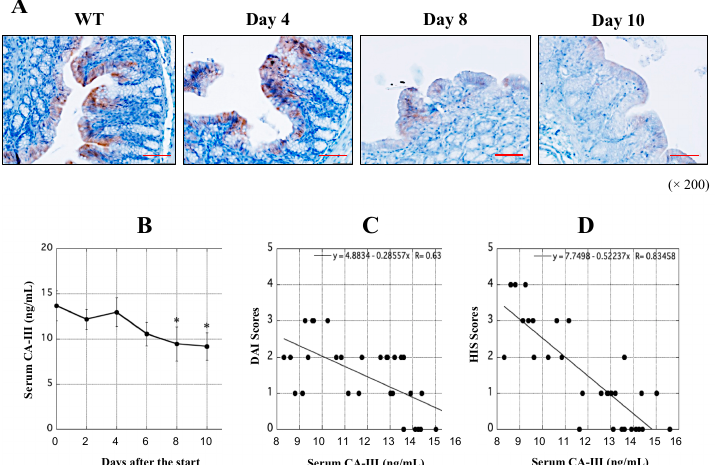
Figure 5. Clinical evaluation of CA-III in rectal tissues and serum of WT and UCR. ( A ) Microscopic images of immunohistochemical staining of CA-III in rectal tissue of WT and UCR on Days 4, 8, and 10 after the start of the experiments. High power magnification was used for all panels (×200). Red scale bar = 50 μ m. ( B ) Serum concentration of CA-III (ng/mL) in WT (Day 0) and UCR (Days 2–10) was quantified by ELISA. X-axis indicates days after the start of the experiment, while Y-axis shows the concentration of CA-III (ng/mL). Data are the mean ± SD. * p < 0.05. ( C , D ) Relationship between serum CA-III concentrations and DAI or HIS scores, respectively, was assessed using Spearman’s analysis. X-axis indicates the CA-III concentration (ng/mL), while Y-axis shows the value of DAI or HIS score. R-values between 0.5 and 1.0 are significant. WT, Wild type Slc:Wistar rats; UCR, Slc:Wistar rats treated with 5% dextran sulfate sodium; DAI, disease activity index; HIS, histological; CA-III, carbonic anhydrase III.